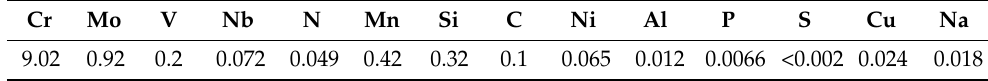
Table 1. Chemical composition of T91 steel (wt.%).